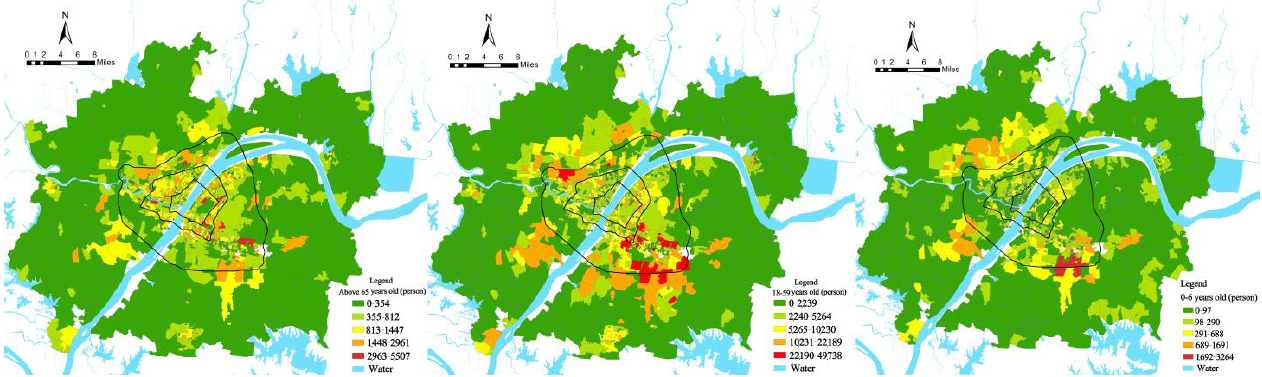
Figure 6. Distribution of elderly people community, working age community, and children com- munity .